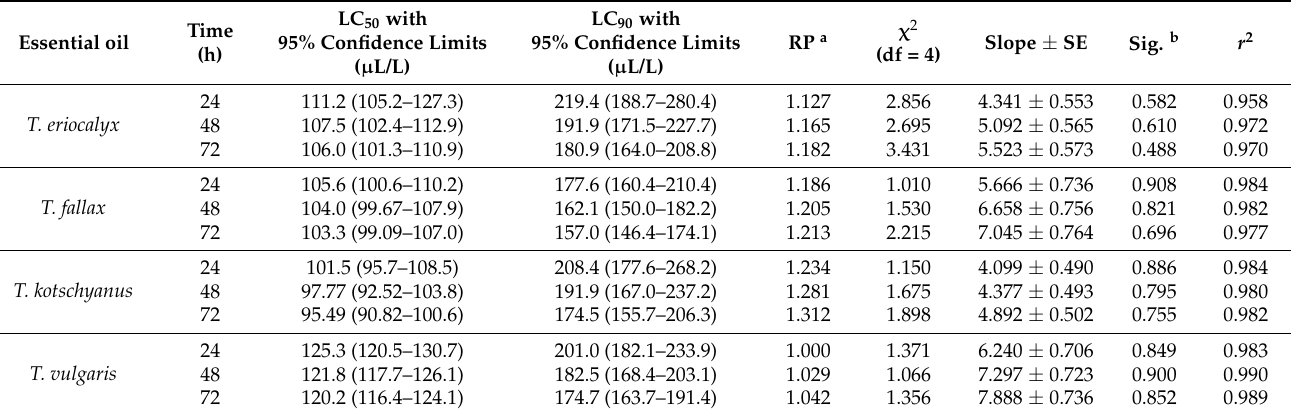
Table 2. Probit analyses of data obtained from of the fumigant toxicity of Thymus eriocalyx , T. fallax , T. kotschyanus , and T. vulgaris essential oils against Rhyzopertha dominica adults.